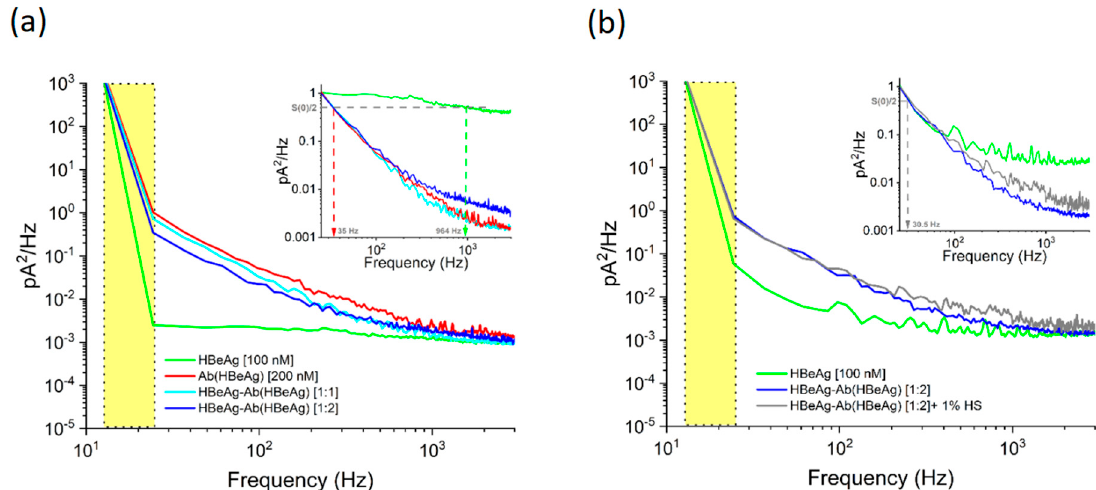
Figure 5. The noise analysis of collisional events ensued by proteins interacting with the α -HL nanopore ( a ) Representative power-spectra of the ionic current fluctuations recorded at ∆ V = +180 mV, associated with the HbeAg, Ab(HBeAg), or HbeAg–Ab(HBeAg) complex collisions with a single α -HL nanopore. ( b ) The power spectrum of current fluctuations induced by HbeAg–Ab(HBeAg) complexes interacting with the α -HL nanopore remained unaltered in the presence of 1% human serum (HS). The yellow domains represent the frequency bandwidth containing excessive low-frequency noise contributions, subsequently excluded from the analysis (see also main